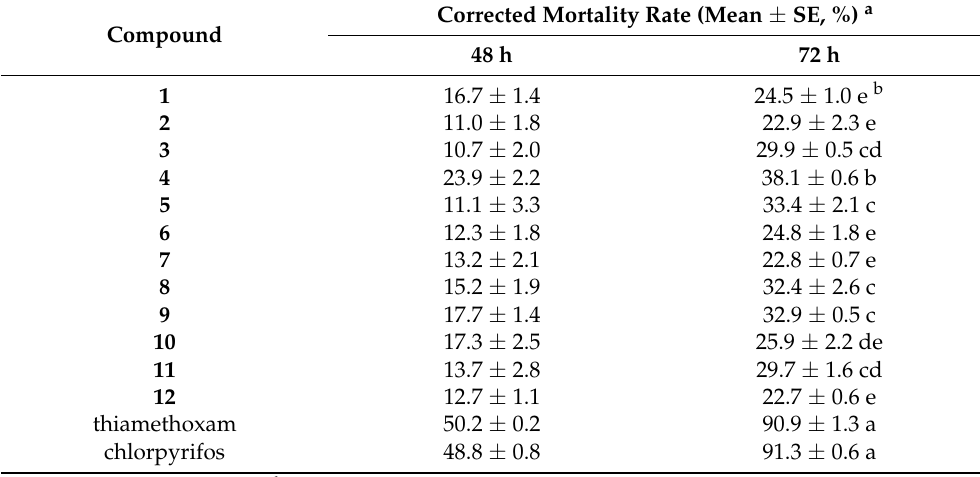
Table 5. Aphicidal activity of compounds 1–12 against E. lanigerum at 200 µ